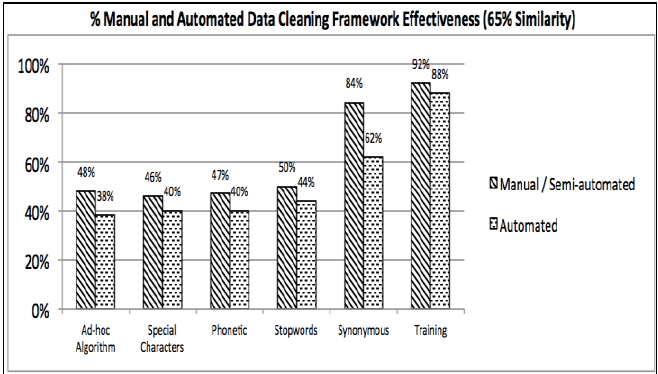
Figure 8: Manual and automated data cleaning environment effectiveness with 65% similarity.